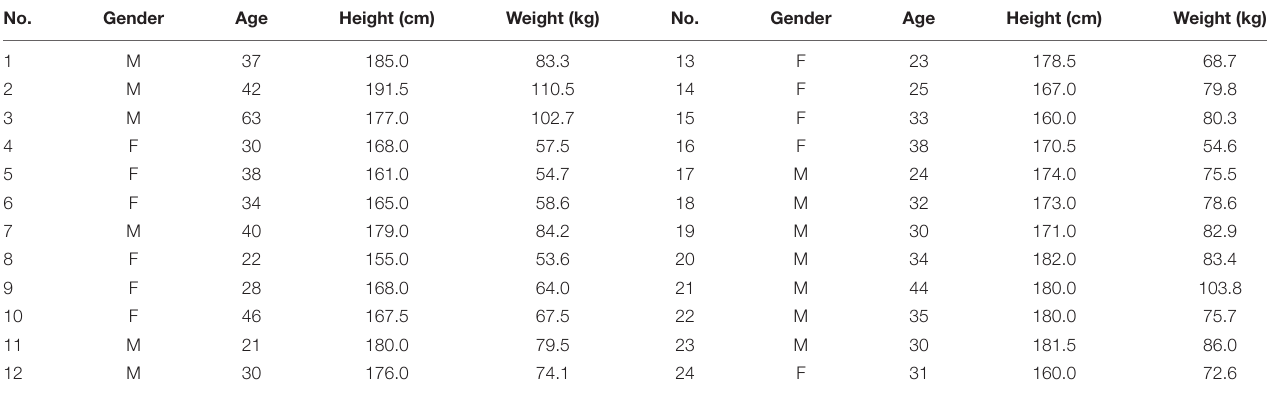
TABLE 1 | Volunteer information.